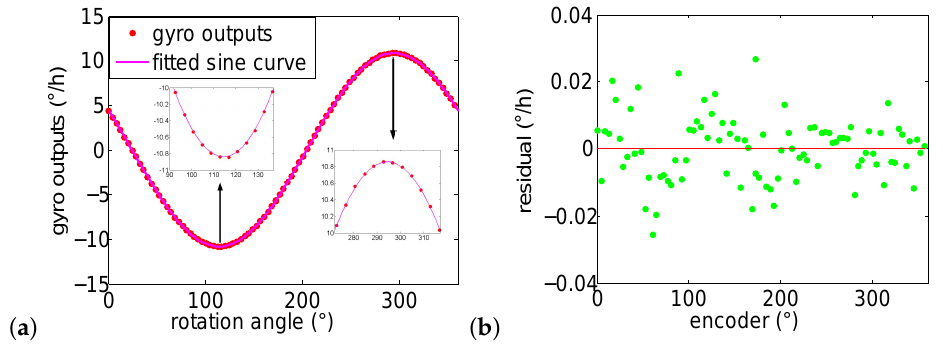
Figure 12. Gyro outputs fitting results when the number of measurement points n = 90. ( a ) Fitting curve when n = 90; ( b ) Residual of the corresponding fitting curve.